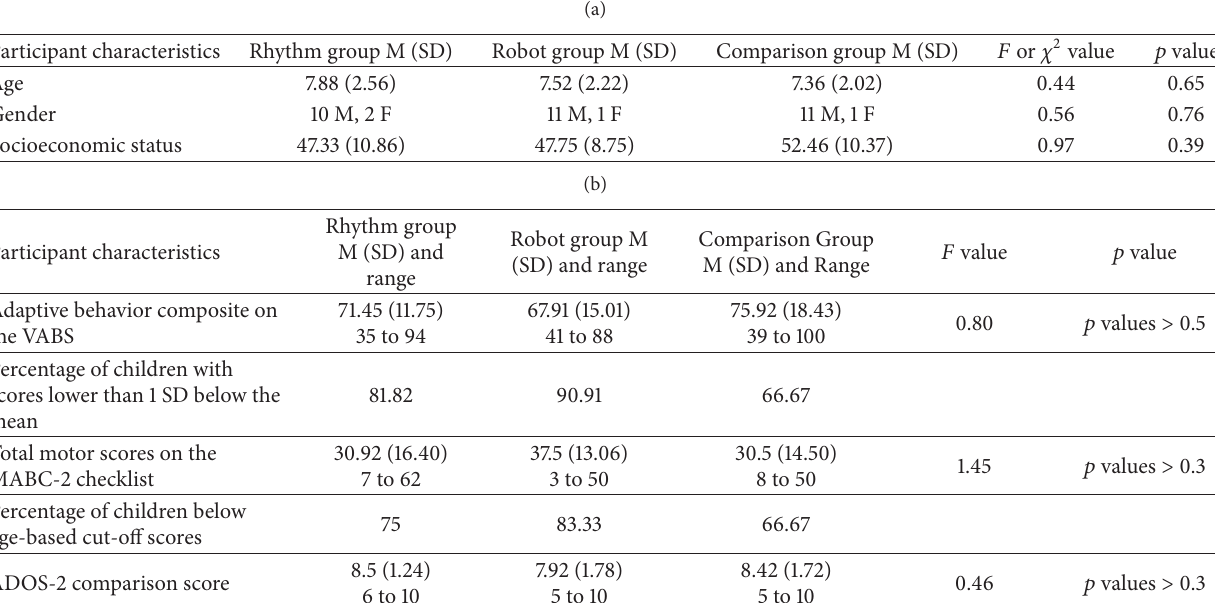
Table 1: (a) Demographic characteristics of children in the rhythm, robot, and comparison groups. (b) Baseline motor performance, adaptive behavior, and autism severity of children in rhythm, robot, and comparison